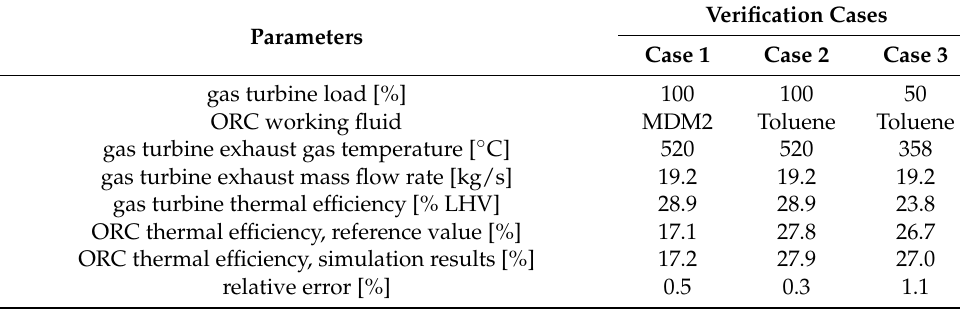
Table 2. Results from the tool